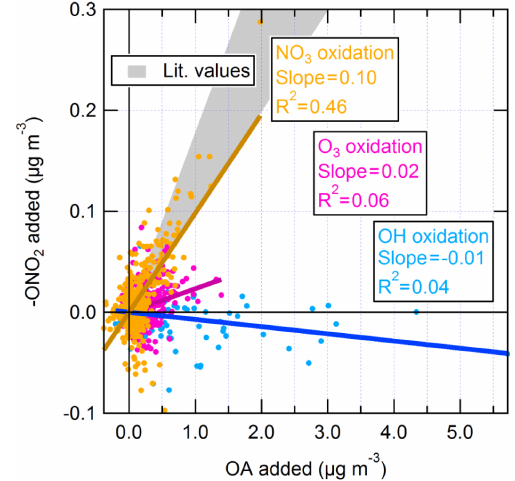
Figure 13. Organic − ONO 2 mass added vs. OA added from OH, O 3 , and NO 3 oxidation in an OFR. No pRONO 2 formation was ob- served (or expected) from OH or O 3 oxidation under the experimen- tal conditions. The slope of 0.10 from NO 3 oxidation is consistent with previous chamber measurements (shown in grey), which range from approximately 0.1 to 0.18 (Fry et al., 2009, 2011; Boyd et al.,